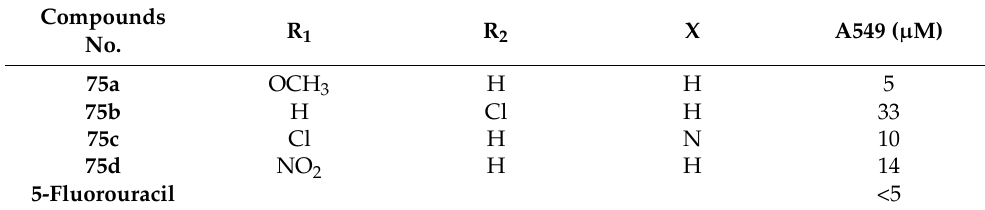
Xian-Feng Huang et al. (2014) synthesized novel hybrids of ferrocene containing pyrazolyl moieties and evaluated their anti-proliferative activity against different cell lines. Most of the synthesized compounds displayed potent anticancer activity. Among them, compound 76 (C) exhibited potent activity against three different cell lines; A549 (human cell) with IC 50 values of 4.44, 20.82, and 4.89 ( µ M), respectively. Control 5-Fluro Uracil had